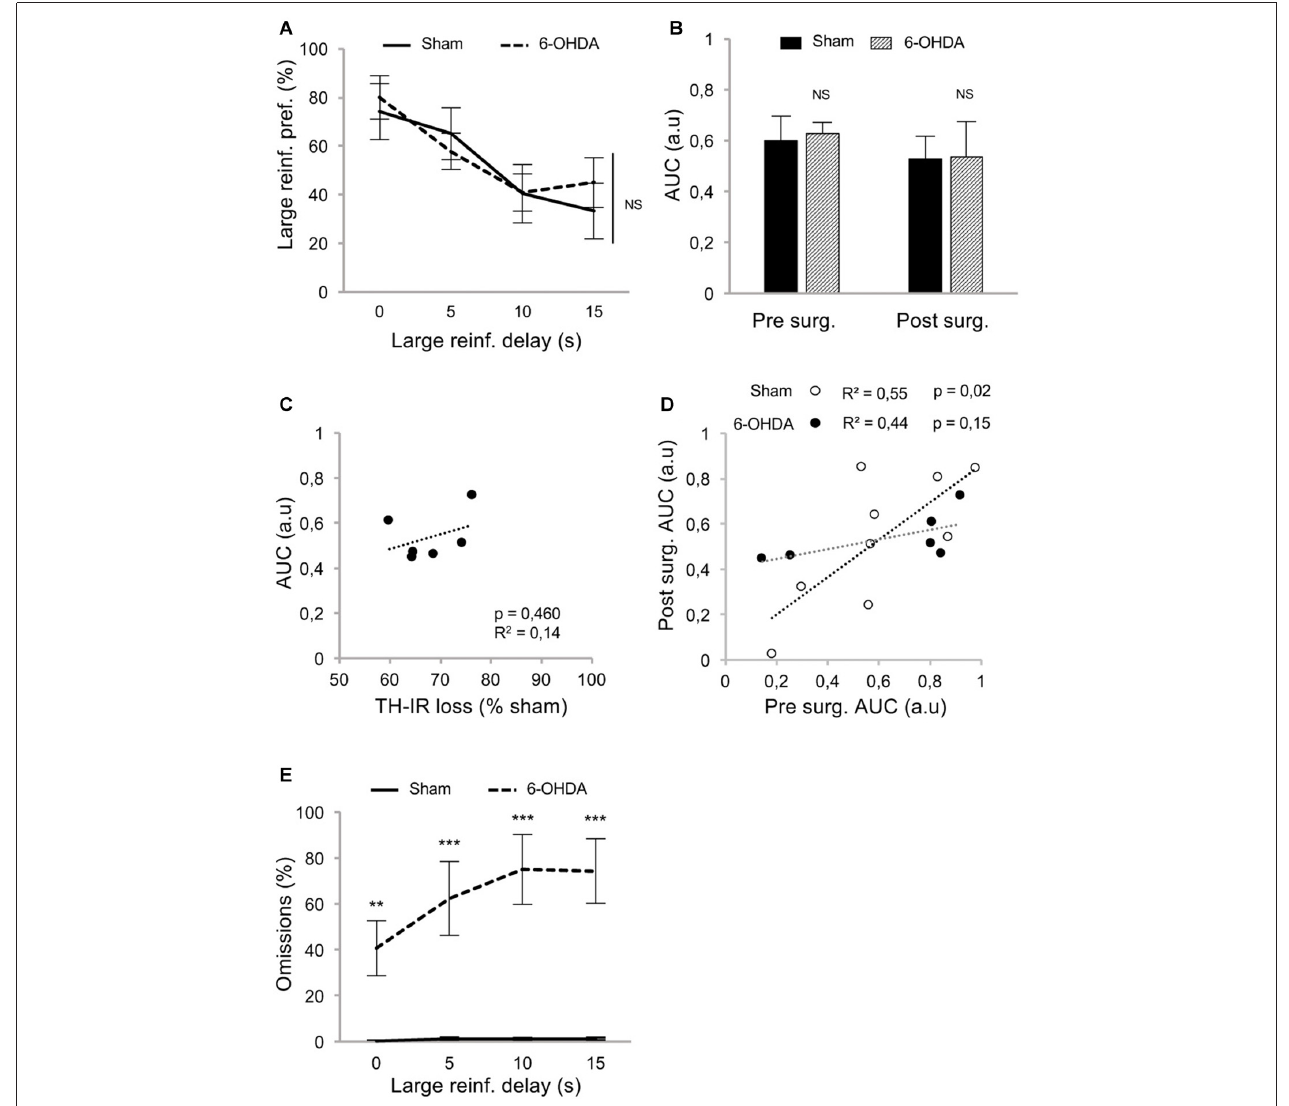
FIGURE 3 | Partial nigrostriatal denervation does not affect impulsivity in a within-session DDT (within-DDT). (A) Similar discounting pattern between sham and 6-OHDA lesioned rats, expressed as percentage of preference for the large reinforcer over the smaller one, in function of delay. In this procedure, rats experienced all delays in each session. Data are represented as mean ± SEM and were averaged from the last five sessions. (B) Similar AUC, between sham and 6-OHDA lesioned rats, pre- and post-surgery period. The AUC is extrapolated from area under discounting curves and expressed as mean value ± SEM for each group. (C) No correlation between the post-surgical AUC and the degree of dorsal striatum TH-IR loss. Dots represent individual values for the AUC and dorsal striatum TH-IR loss expressed as percentage of sham mean value. (D) Positive correlation between pre and post-surgery of individual AUC values for sham operated rats (empty circle) and 6-OHDA lesioned rats (full circle). Correlation is only significant for sham rats ( p < 0.05; for 6-OHDA rats: p = 0.15). (E) 6-OHDA lesioned rats exhibited a higher percentage of omissions than sham rats during within-DDT. Data are represented as mean of omissions ± SEM in function of delay (averaged for the last five sessions). NS, non-significant, ∗∗ p < 0.01; ∗∗∗ p < 0.001; Sham ( n = 9) vs. 6-OHDA ( n = 6), reinf, reinforcer; AUC, area under the discounting curve; a.u, arbitrary